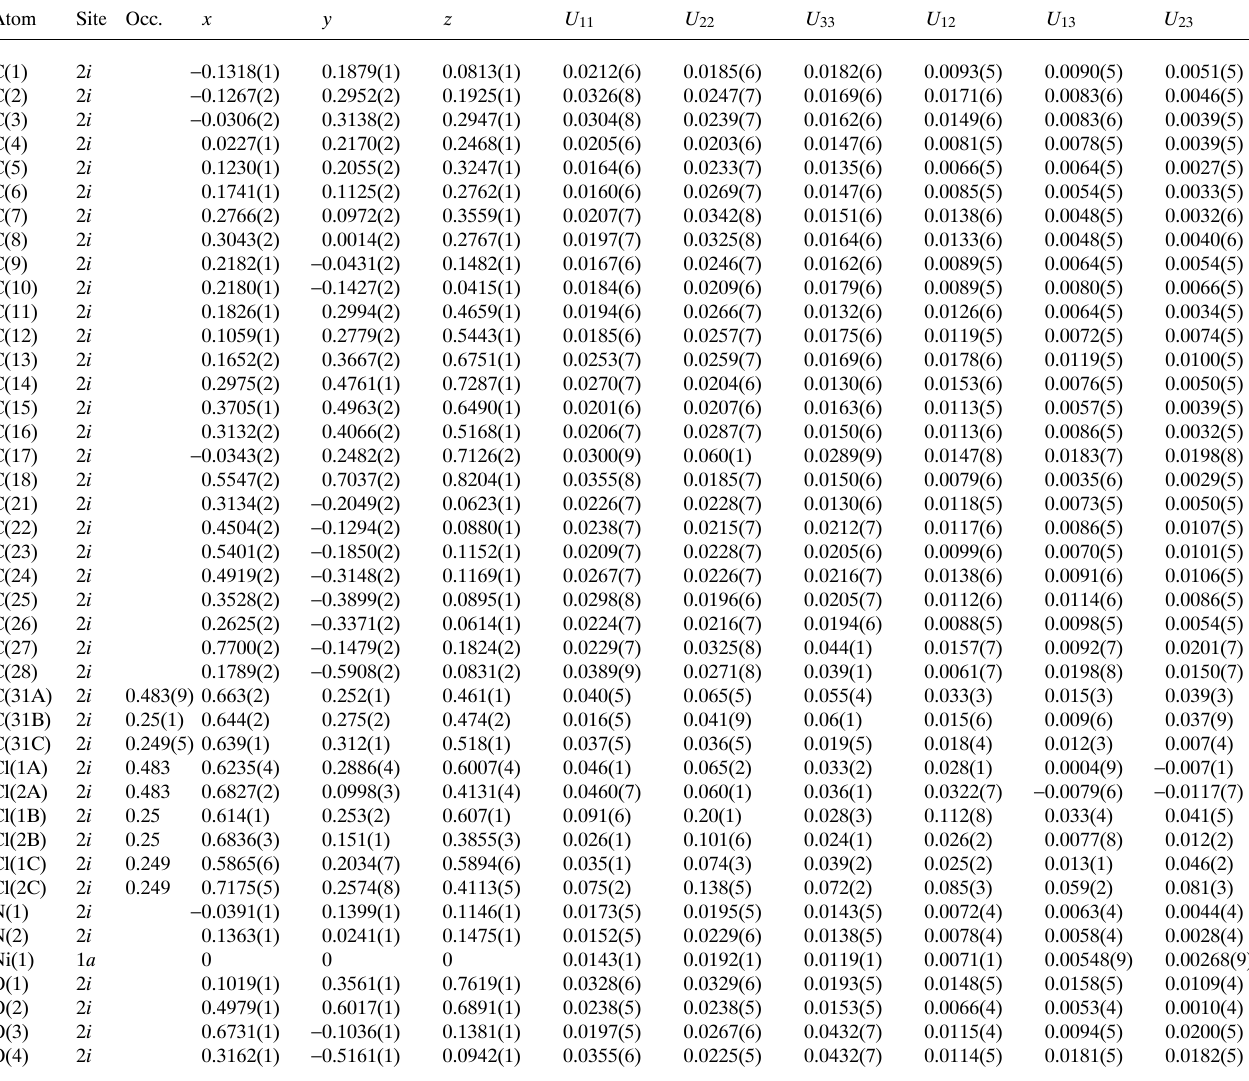
Table 9. A tomic coordin a tes a nd displ a cement p a r a meters (in Å 2 ) . A tom S ite O